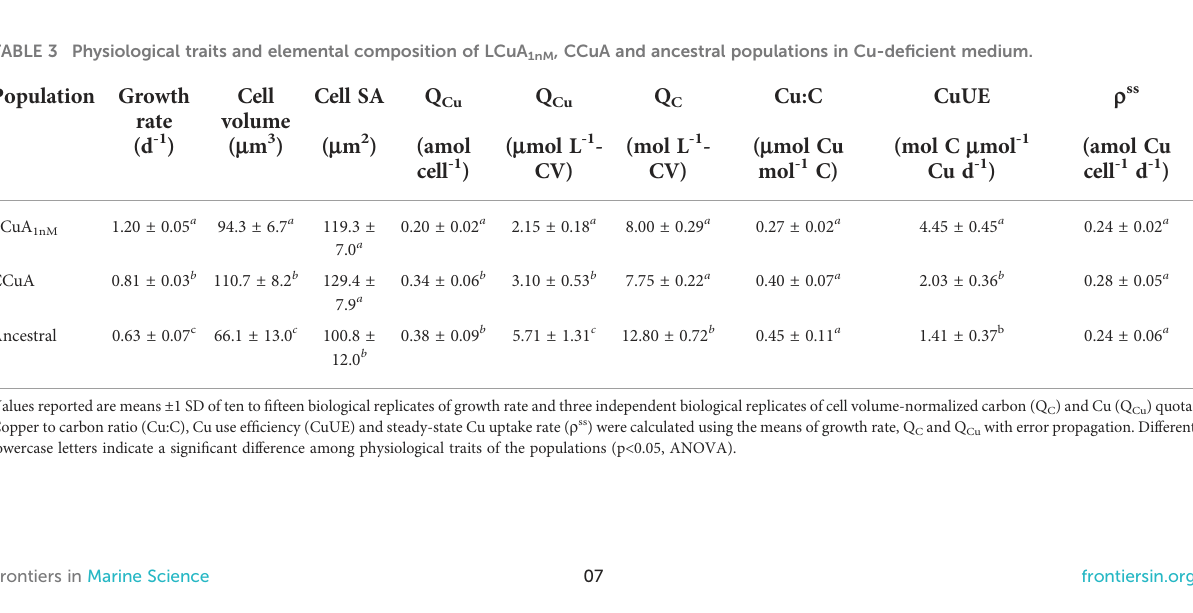
TABLE 3 Physiological traits and elemental composition of LCuA 1nM , CCuA and ancestral populations in Cu-de fi cient medium. Population Growth rate